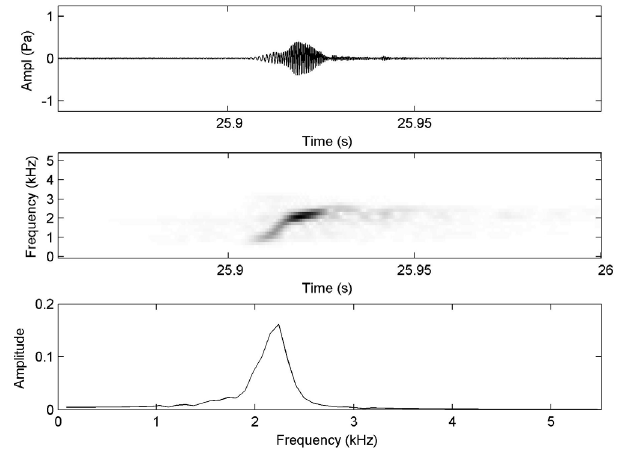
Figure 2. Advertisement call of Leptodactylus sertanejo from Parque Estadual do Mirador, Maranhão, northeastern Brazil. From top to bottom: waveform, spectrogram, and power spectrum of a single note.